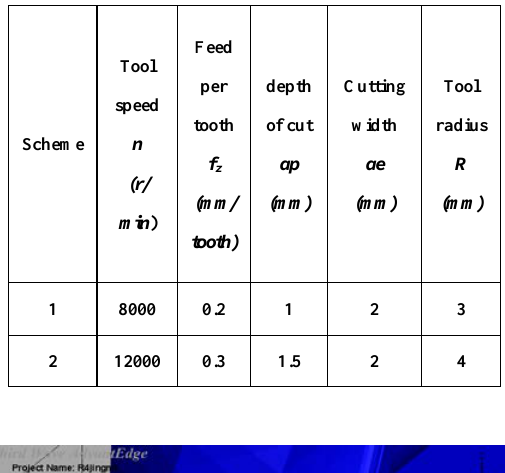
Table 2. Simulation and experiment schemes